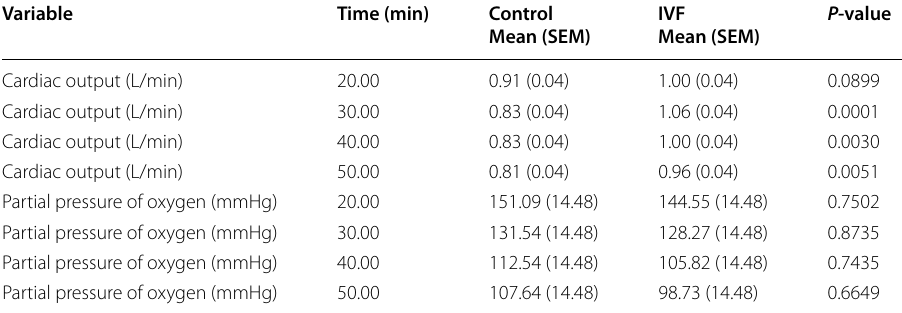
Table 3 Between-group comparison of cardiac output and partial pressure of oxygen following